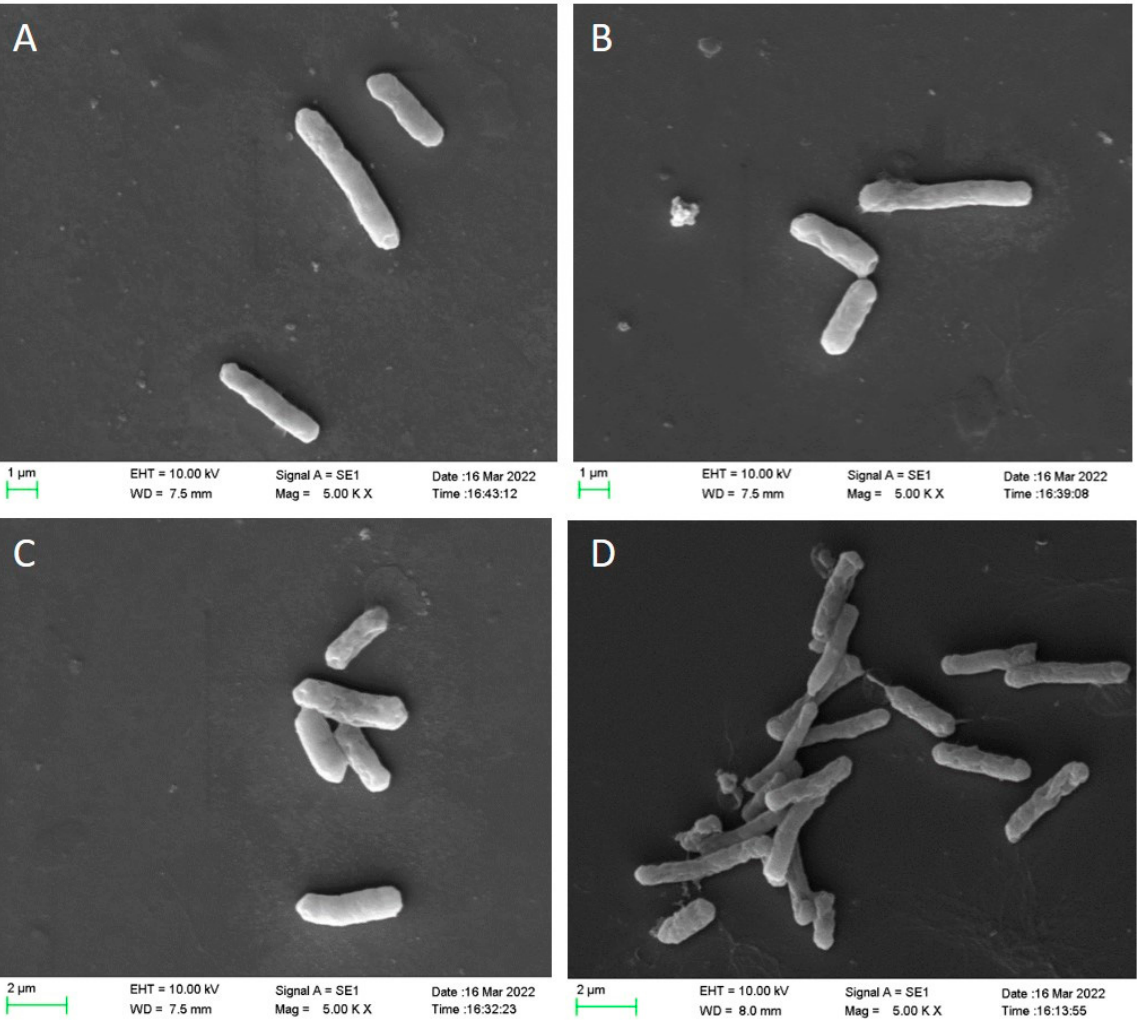
Figure 2. SEM images of C. perfringens spores after different treatments for 30 min. ( A ), control; ( B ), treatment of 90 °C; ( C ), treatment of 1% LA; ( D ), combined treatment (90 °C and 1% LA).